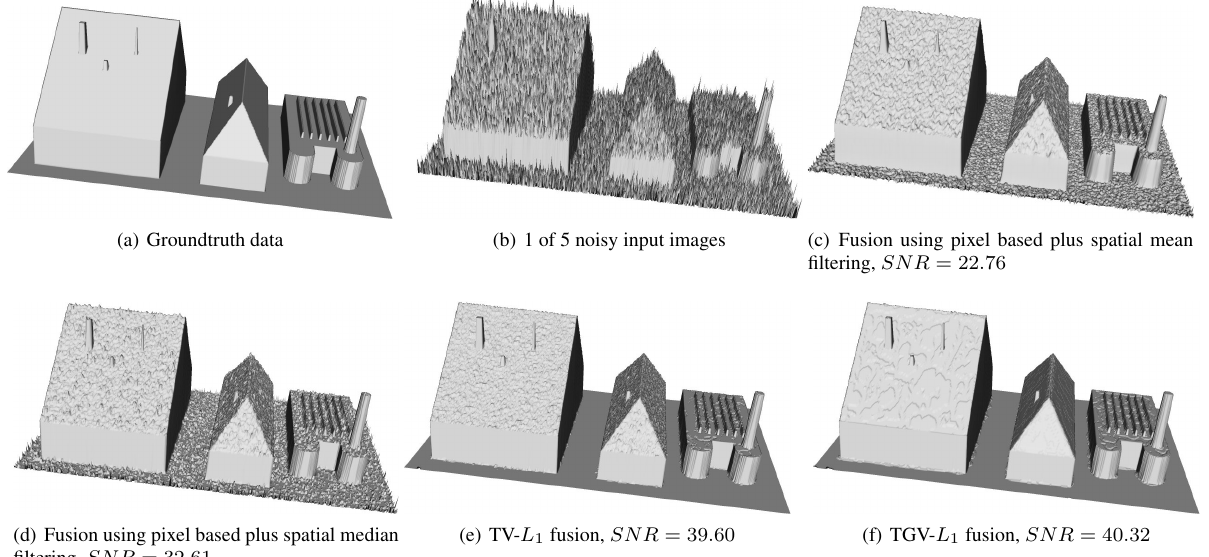
Figure 2: Comparison of local fusion method versus global optimization methods. Both numerical results and visual appearance show the benefit of the latter ones.